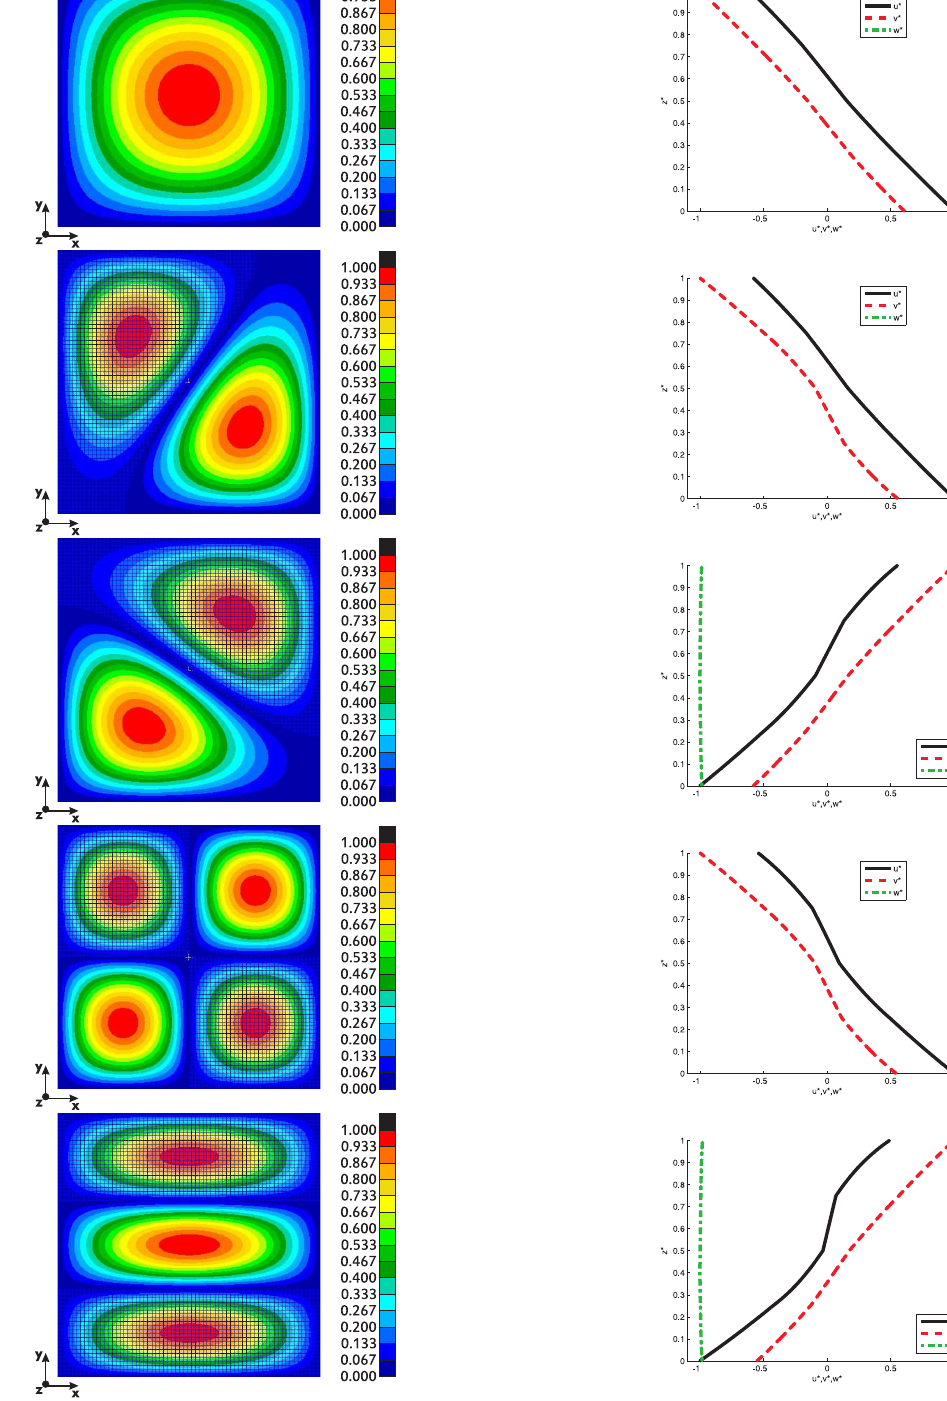
Figure 14: Ninth benchmark, simply supported composite plate 90 ∘ /0 ∘ /90 ∘ /0 ∘ with thickness ratio a/h=10. First five frequencies (with transverse displacement w ≠ 0) via 2D FE solution (on the left) and via 3D exact solution (on the right).